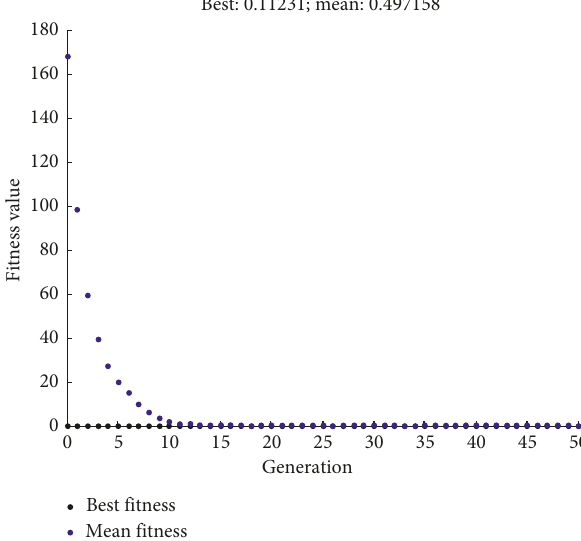
Figure 9: Best fitness value and mean fitness